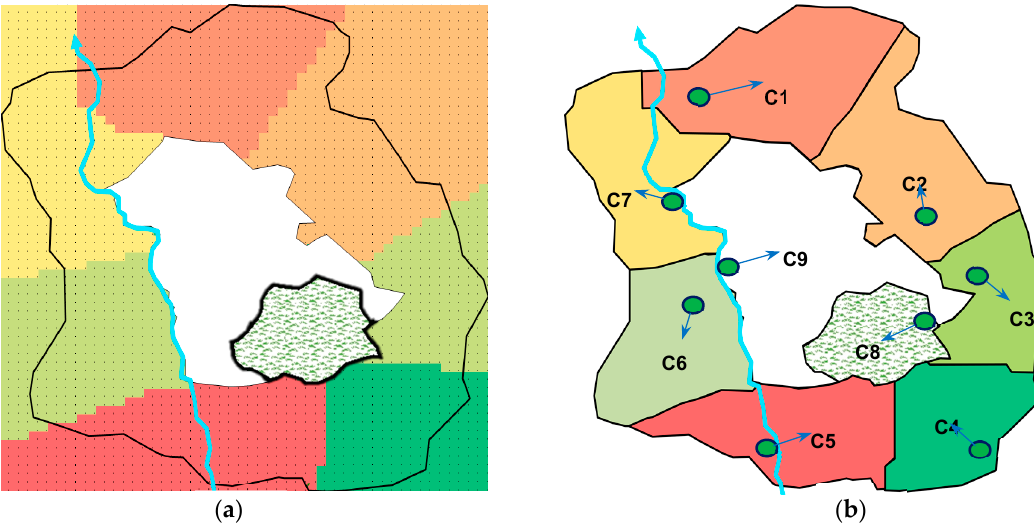
Figure 11. Maps showing clusters after re-distributing small groups ( a ) and WSS cluster boundaries with source centers (green circles) ( b ).